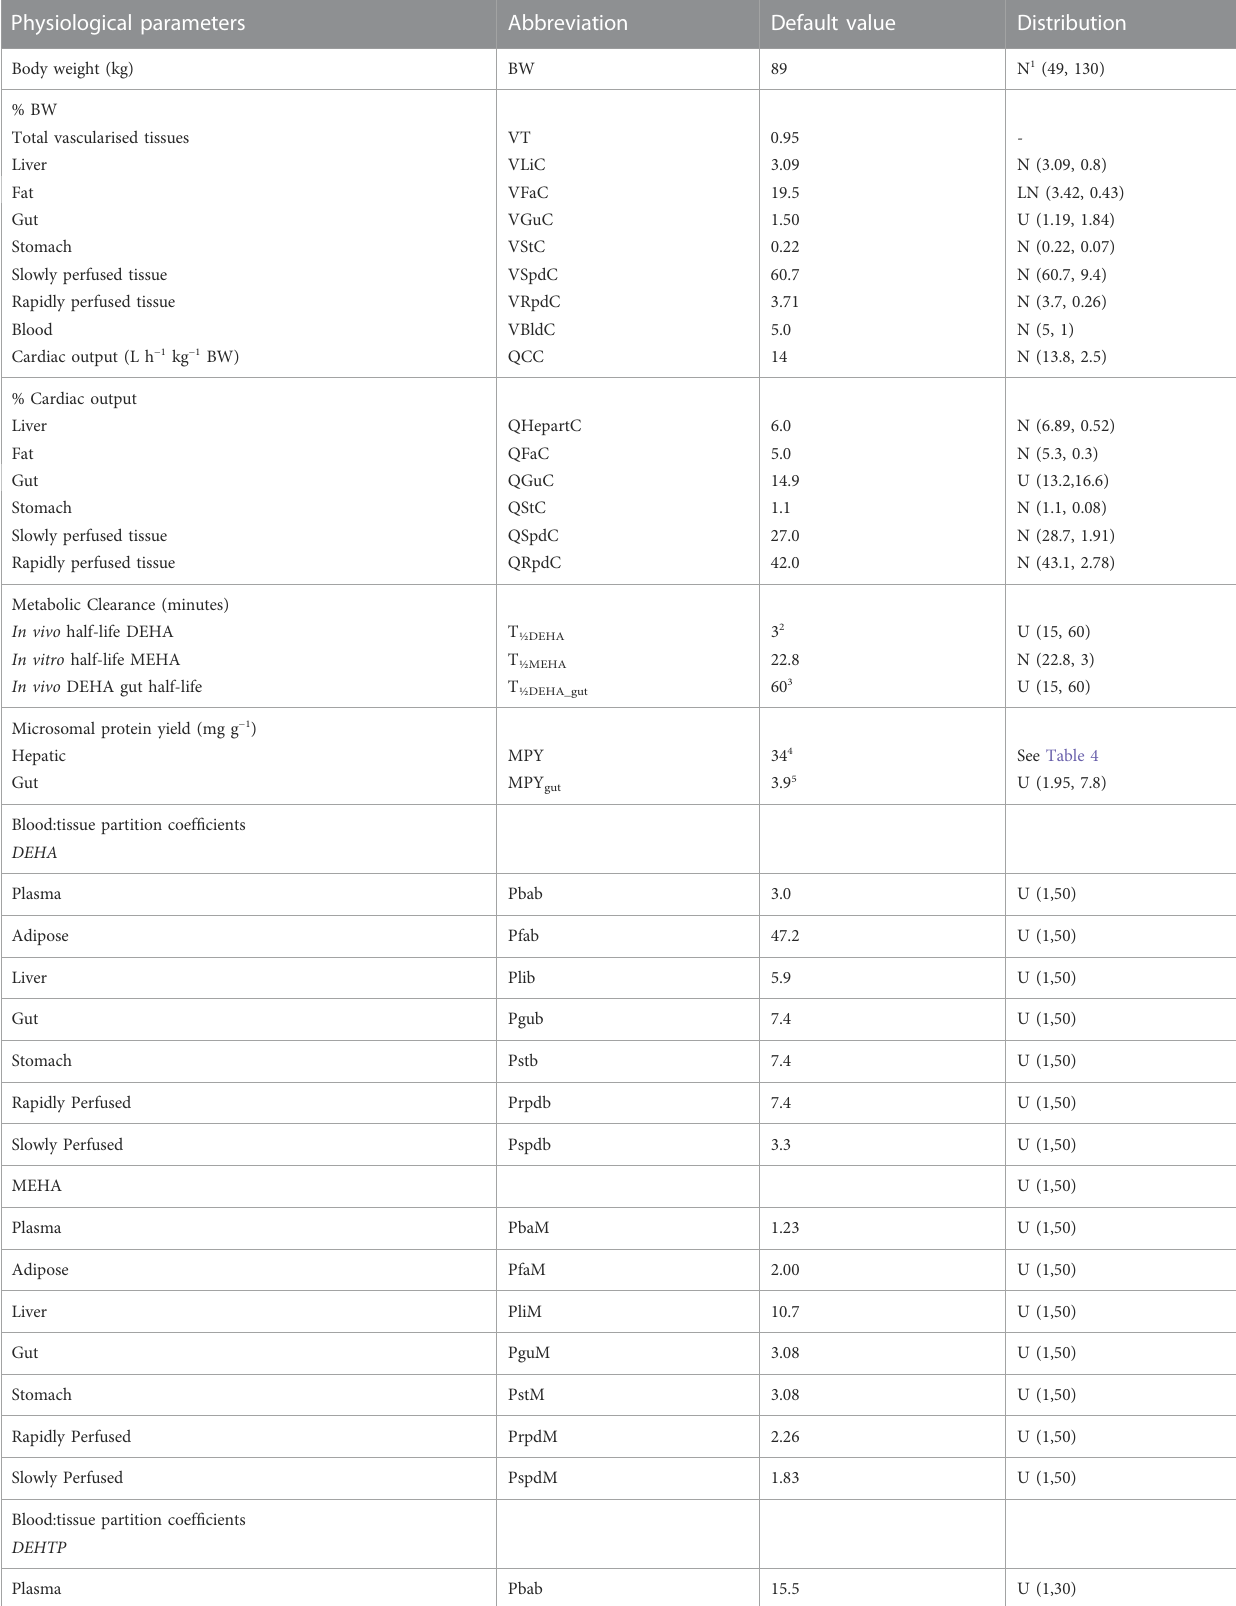
TABLE 3 Physiological and kinetic default values used in PBPK model and probability distributions applied for uncertainty and sensitivity analyses. Physiological and kinetic constants used in PBPK model. Physiological